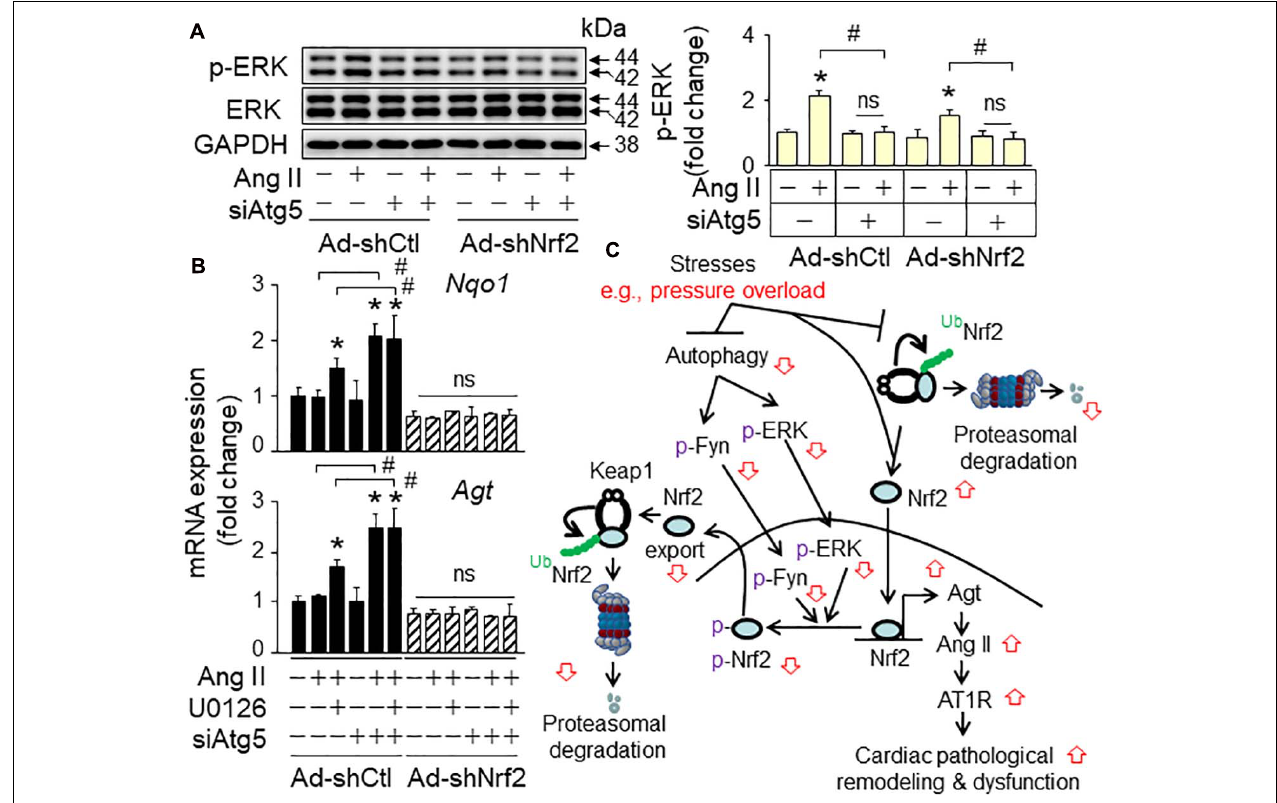
FIGURE 5 | The impact of autophagy inhibition on Ang II-induced ERK activation, Nrf2 activity and angiotensinogen (Agt) expression in the primary culture of neonatal rat ventricular myocytes (NRVMs). NRVMs were infected with adenovirus of scramble (Ad-shCtl) or Nrf2 shRNA (Ad-shNrf2) and then transfected with the control siLuc (siCtl) or Atg5 siRNA (siAtg5) prior to the treatment of Ang II (1 µ M) and U0126 (1 µ M) as described in the section “Materials and Methods.” (A) Representative immunoblots and densitometric analysis ( n = 4). * p < 0.05 vs the vehicle control (–) treated Ad-shCtl + siCtl cells using the Student t test; # p < 0.05 between indicated groups using one-way ANOVA followed by Bonferroni test. ns, non-significant. (B) qPCR analysis of Nqo1 and angiotensinogen (Agt) expression ( n = 4). * p < 0.05 vs the vehicle control (–) group using the Student t test; # p < 0.05 between indicated groups using one-way ANOVA followed